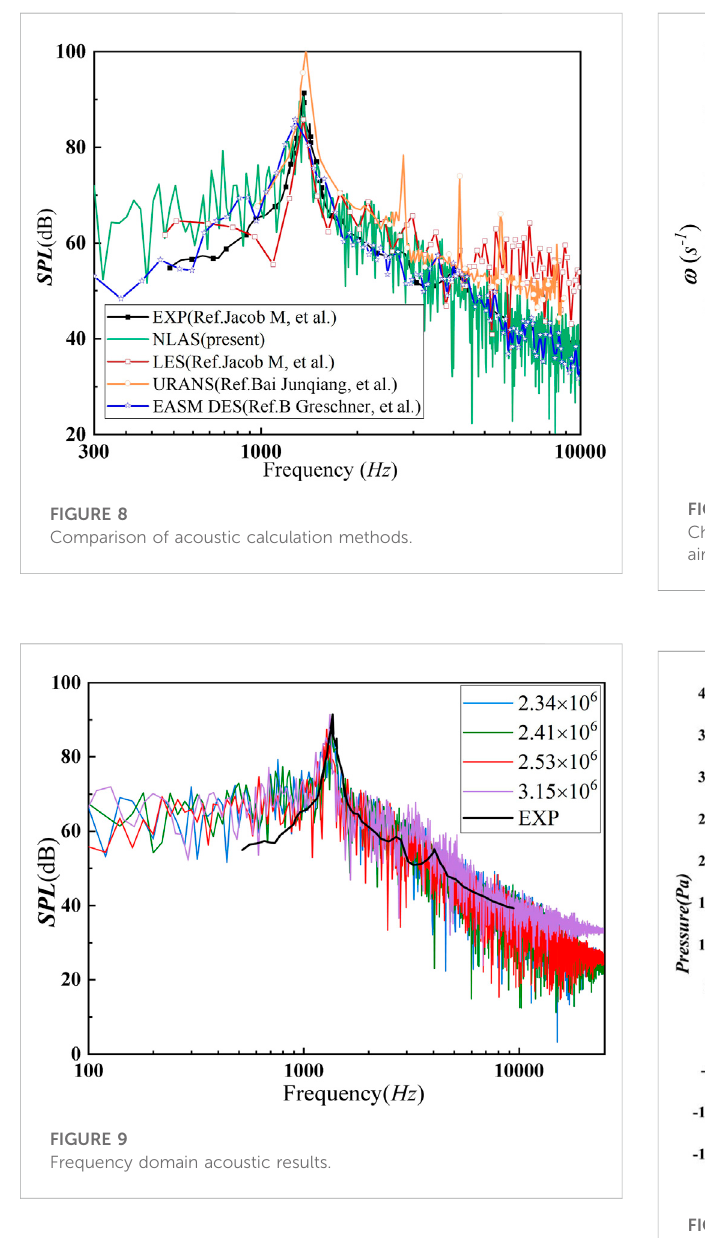
Airfoil surface pressure distribution at z = −